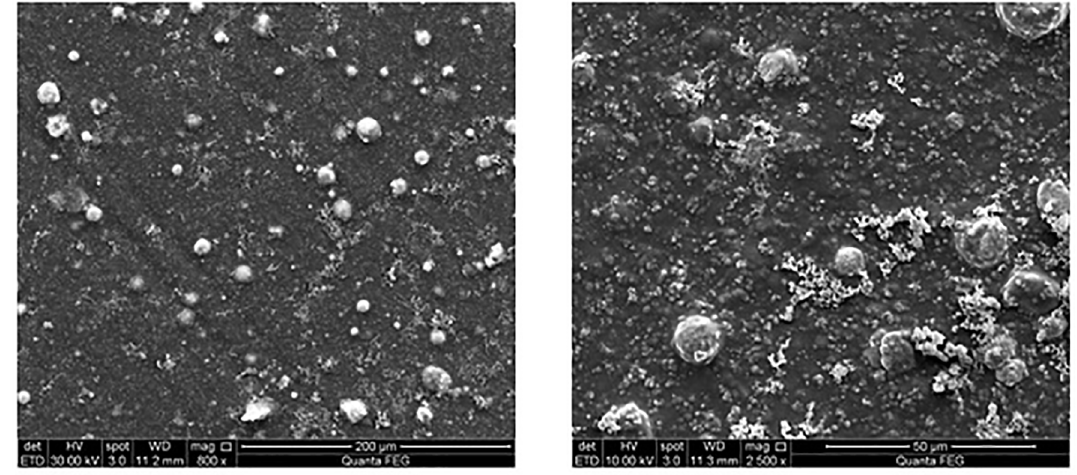
-ZrO coating with a mix ratio of 0.5:0.5 containing 2 wt. % nanoparticles after the corrosion test. 2 2